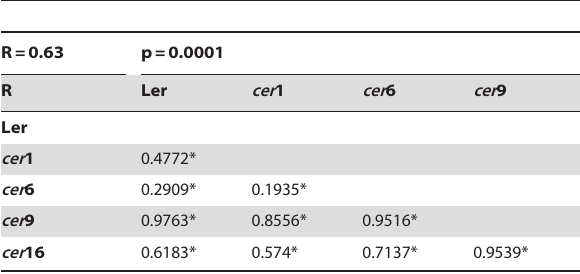
Table 1. Analysis of similarity (ANOSIM) for DGGE banding